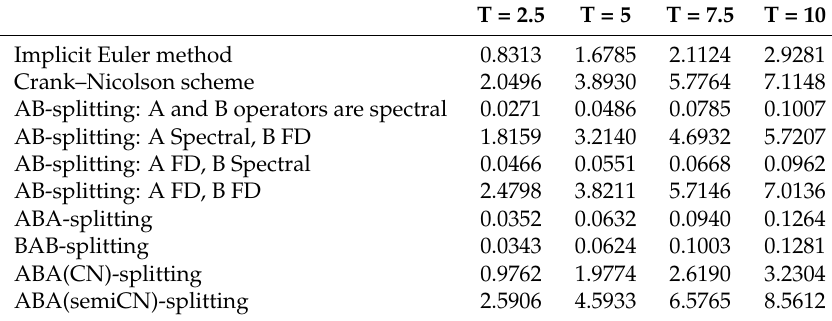
Table 3. Computational times of one soliton with the different methods.